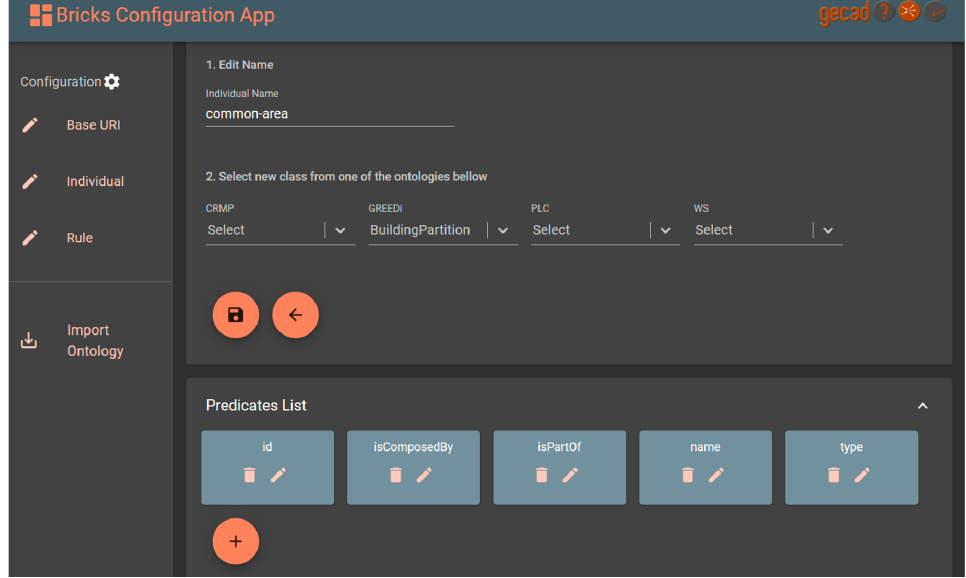
Figure 3. The configuration of a building’s partition using the BRICKS Configuration Module